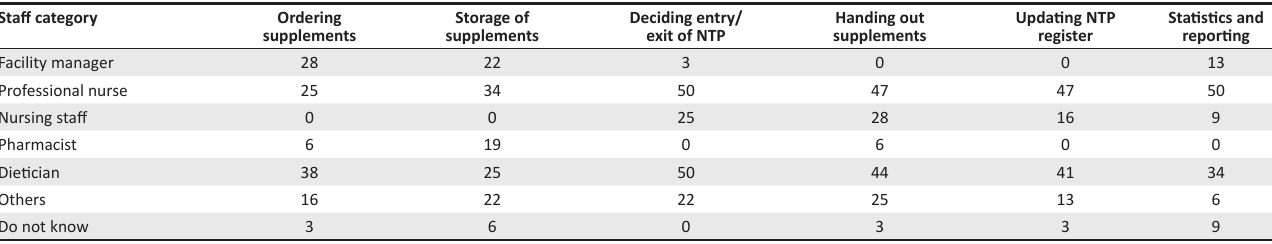
TABLE 3: Distribution of Nutrition Therapeutic Programme responsibilities amongst primary health clinics site staff categories. Staff